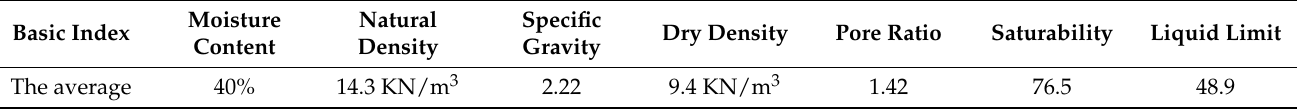
Table 2. The physical properties of fly ash.